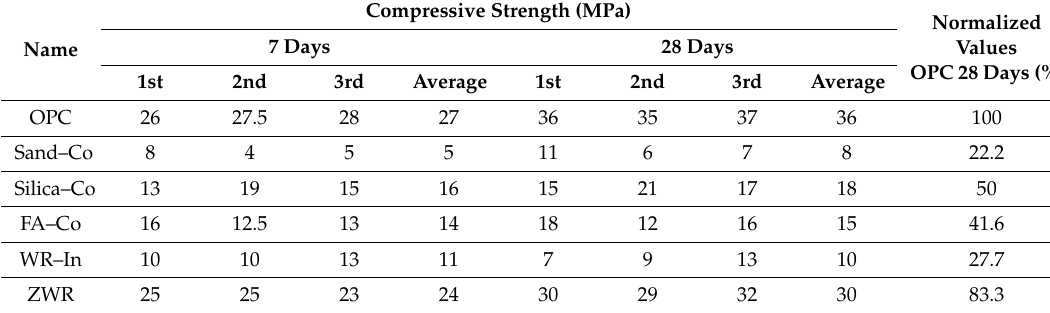
Table 10. Result of compressive strength